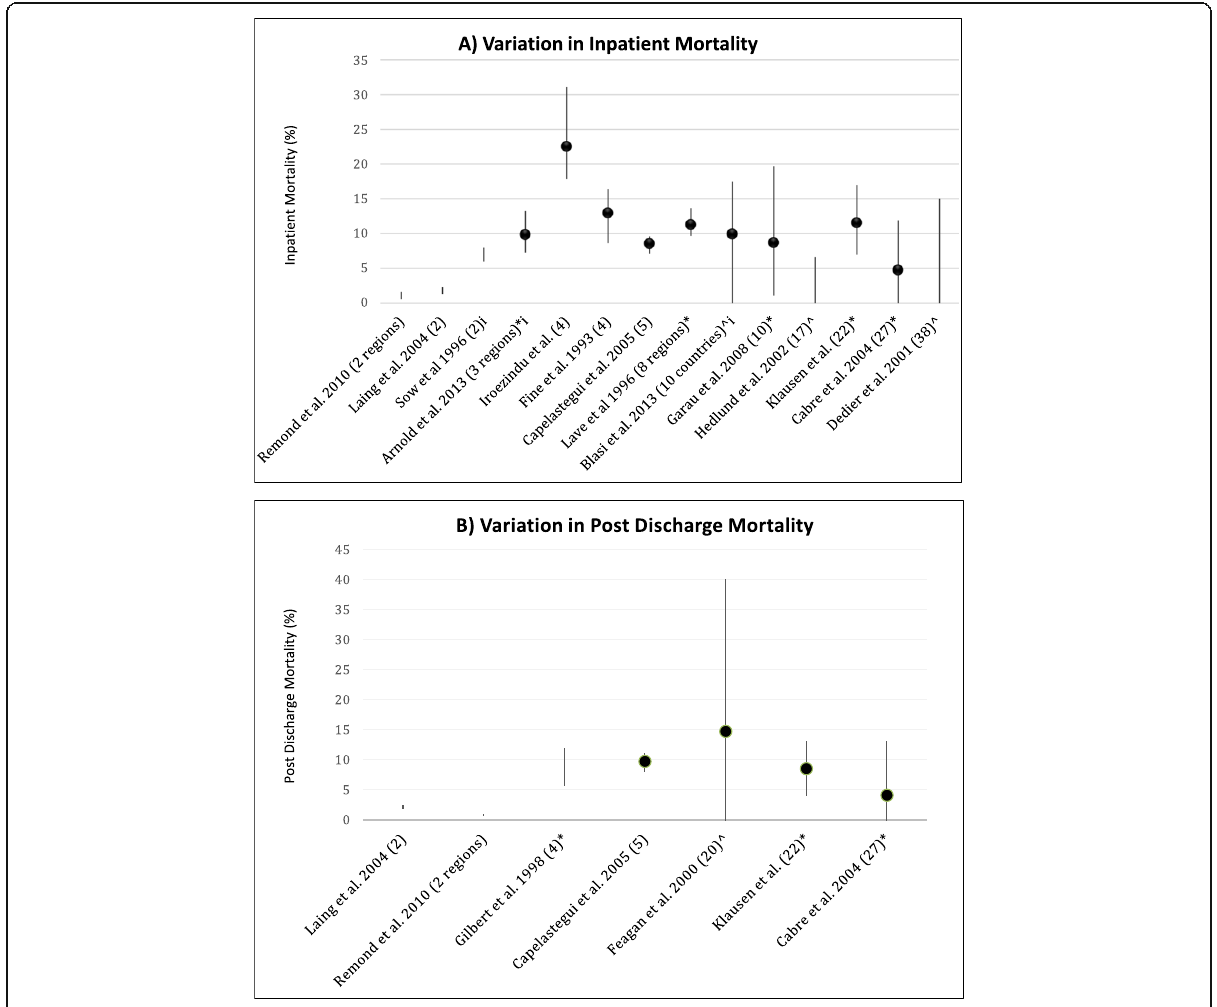
Fig. 1 a Inter-hospital variation in inpatient mortality across studies (%). Range represented as line, dot represents mean value where possible. * denotes a statistically significant result. ^ denotes no reported p value. The letter ‘ i ’ represents an international study. The number in brackets represents the number of units compared in the hospitals, unless otherwise stated. b - Inter-hospital variation in post discharge mortality across studies (%) – 14 days post discharge or 30 days post admission. Range represented as line, dot represents mean value where possible. * denotes a statistically significant result. ^ denotes no reported p value. The number in brackets represents the number of hospitals compared in the study, unless otherwise